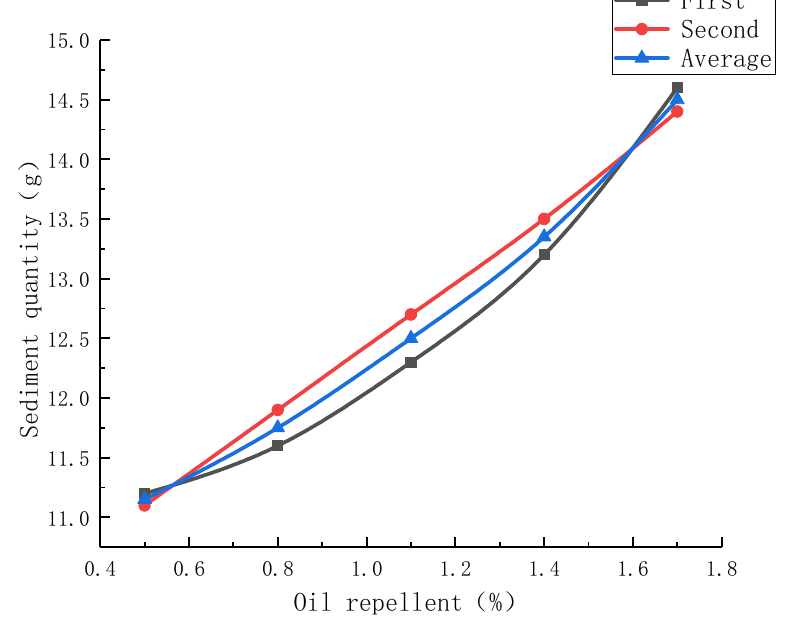
Figure 6. Sediment quality curves at different oil displacement agent content.